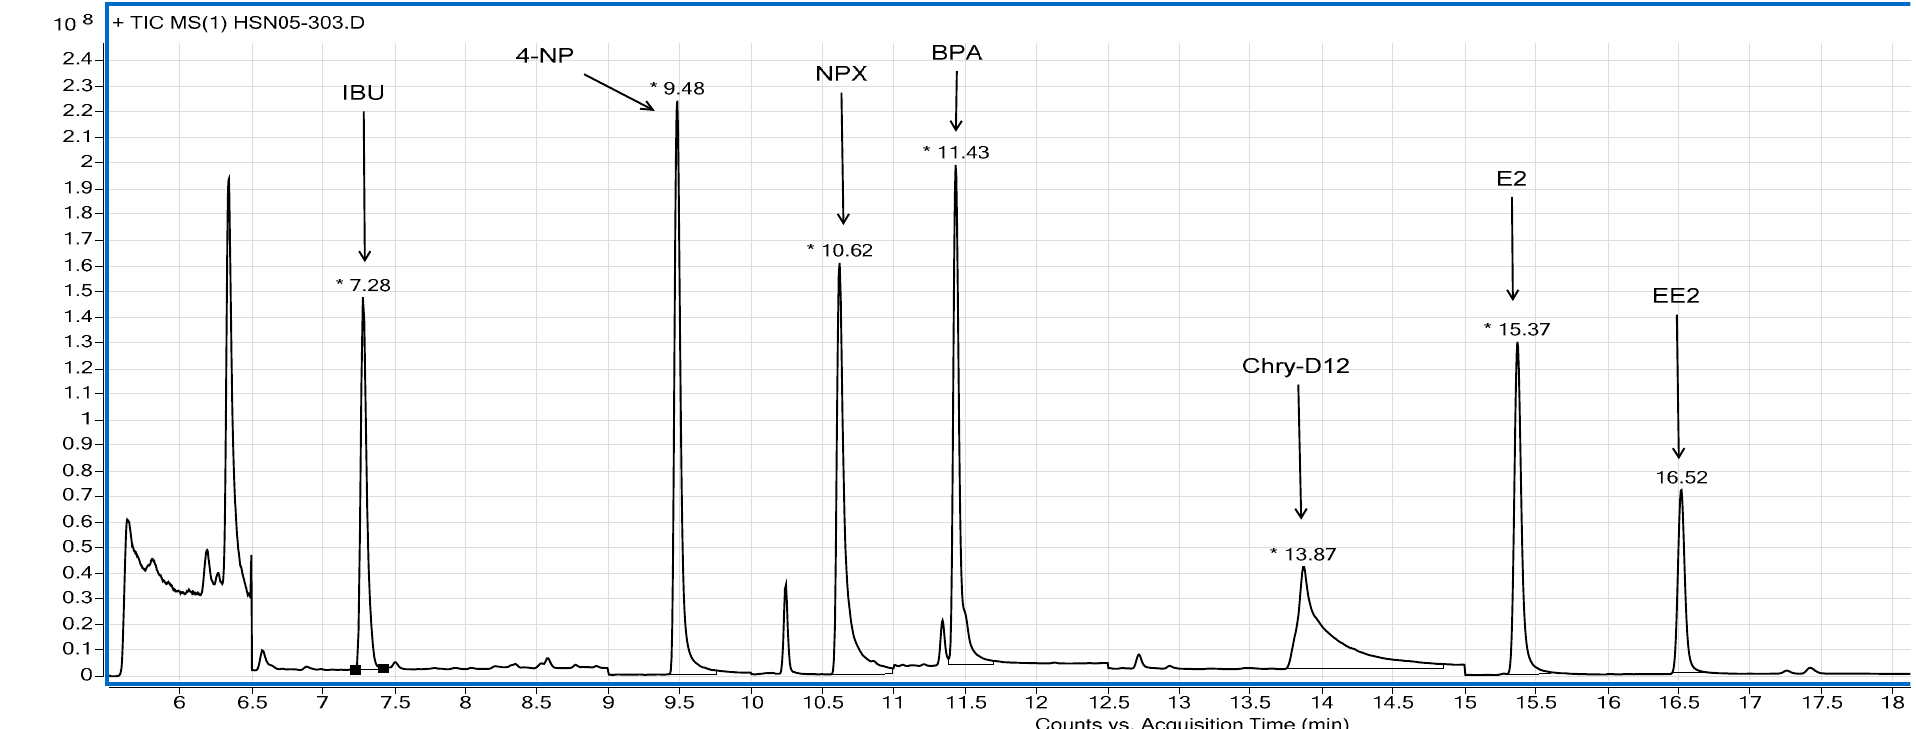
Figure 2. Chromatography that demonstrates the optimal separation of the six compounds studied by GC-MS.